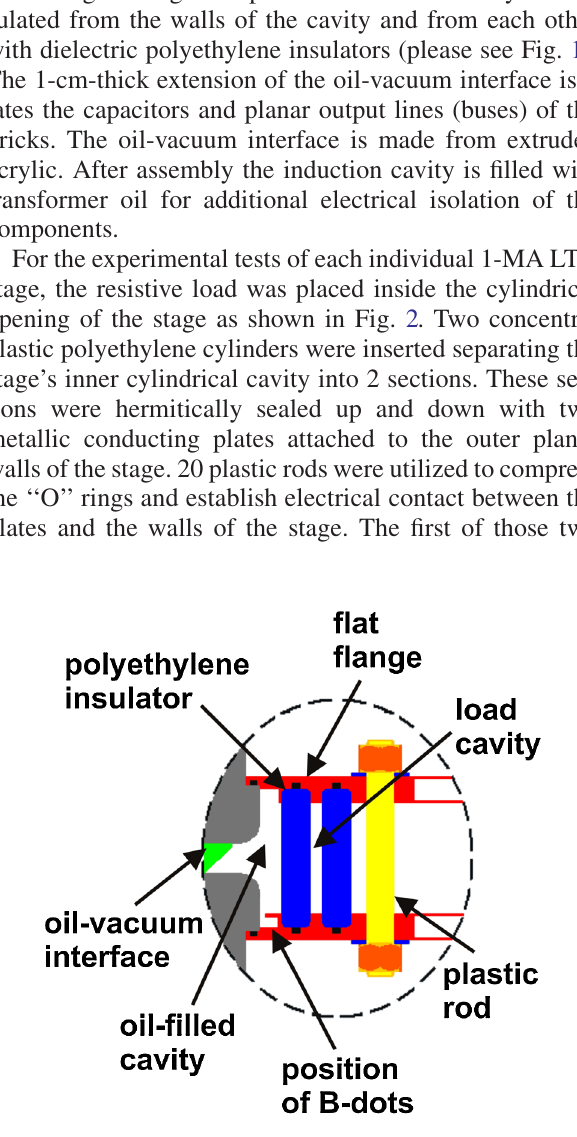
FIG. 3. Peak load power dependence on the load resistance. The dots are the experimental results and are compared with PSPICE simulation (solid curve).